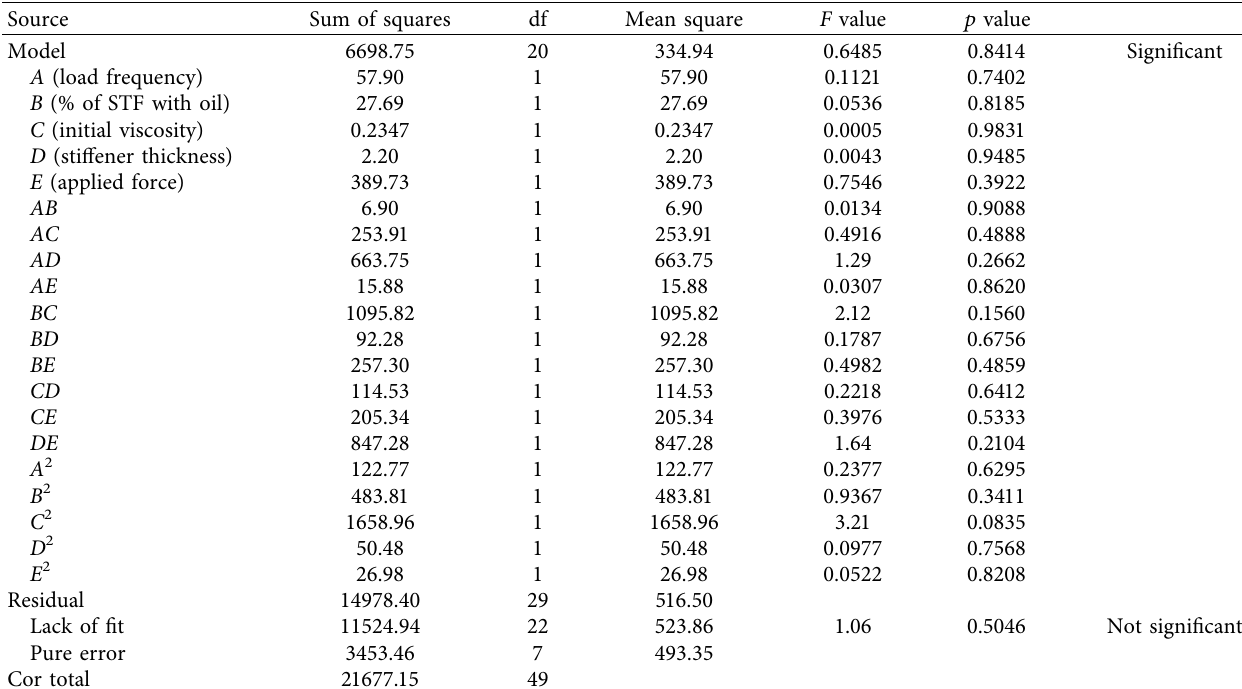
Table 3: Analysis of variance for complex